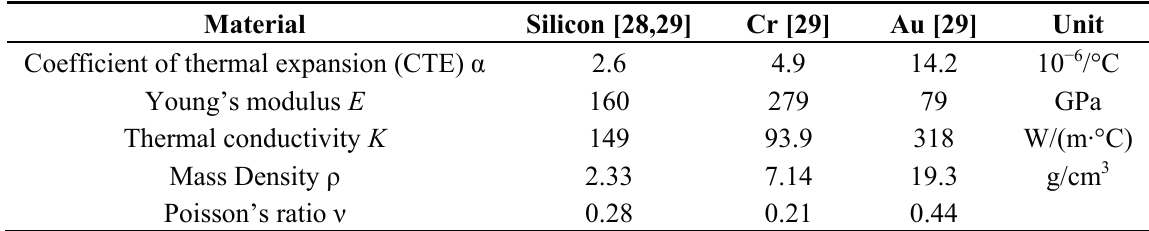
Table 2. Material properties of the bimorph